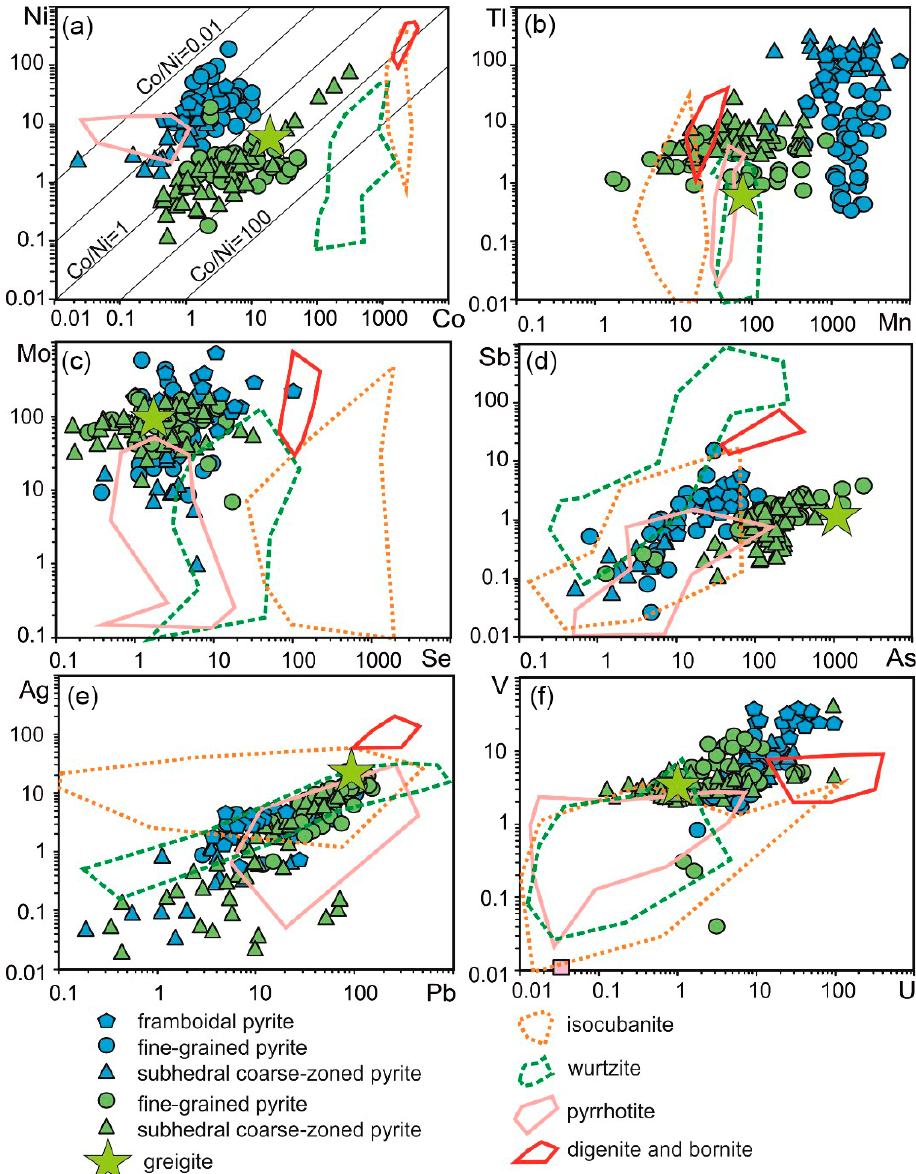
Figure 6. Diagrams of trace elements in sulfides of pyrite microfacies-196 and -195. Pobeda-1 hydrothermal field. ( a ) Co vs Ni ratio; ( b ) Mn vs Tl ratio; ( c ) Se vs Mo ratio; ( d ) As vs Sb ratio; ( e ) Pb vs Ag ratio; ( f ) U vs V ratio.